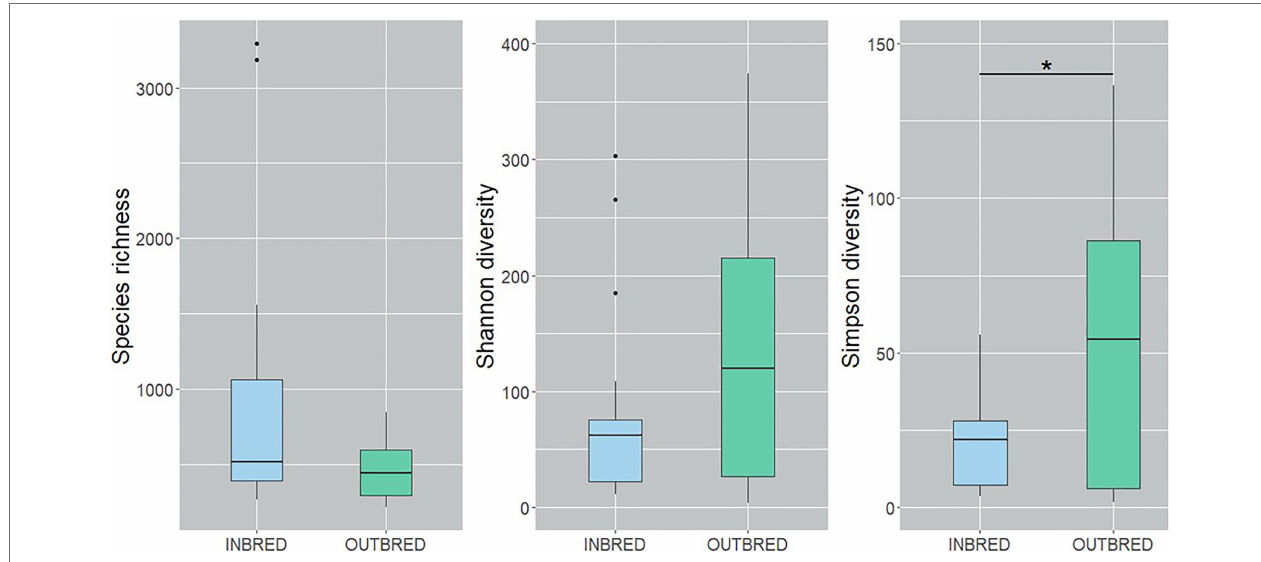
FIGURE 3 | Alpha diversity of the bacteria in the posterior intestine of the inbred and outbred groups of Nile tilapia. Simpson diversity analysis showed that the dominant ASVs are higher in the outbred groups ( p = 0.04, indicated with an asterisk). The boxplots show minimum, lower quartile, median, upper quartile and maximum values.